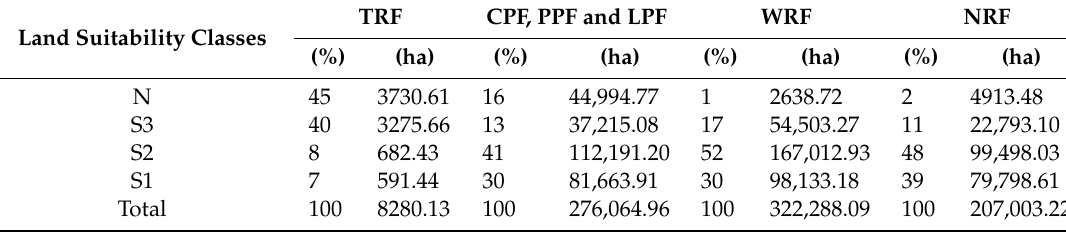
Figure 8. Land suitability analysis for the extension of potential areas in NRF, CPF, LPF, PPF, WRF and TRF forest zones. Table 10. Land suitability analysis for extension of potential forest areas in the forest